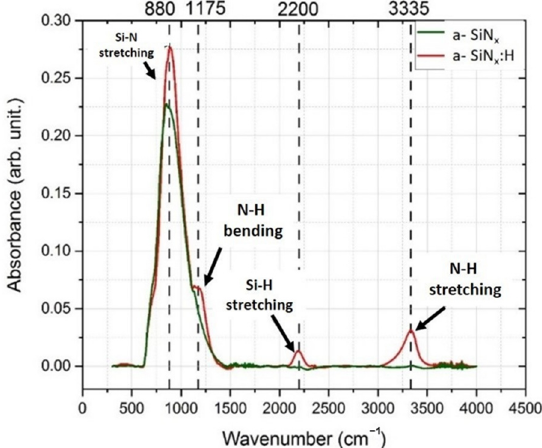
Figure 4. Absorbance spectra of reference a-SiN x (R2) and a-SiN x :H (S6) thin films.